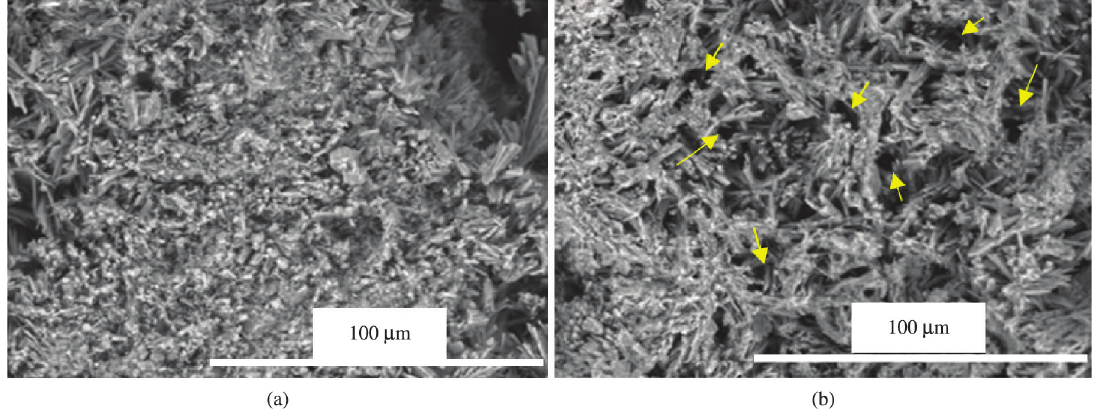
Figure 2. Micrographs of a fracture area of G/PVA composite. a)Before the removal of PVA and b)Arrows indicating pores formed by the removal of PVA.